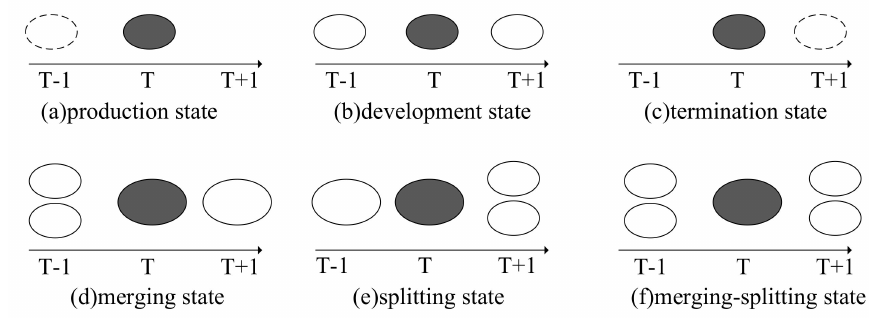
Figure 3. The six types of instantaneous states.